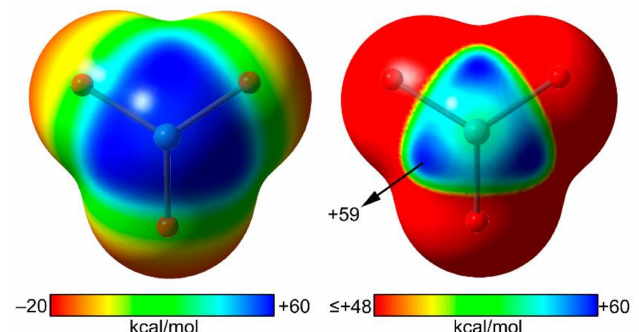
Figure 3. Molecular electrostatic potential (MEP) surfaces of XeO 3 using two di ff erent scales. Isosurface 0.01 a.u.